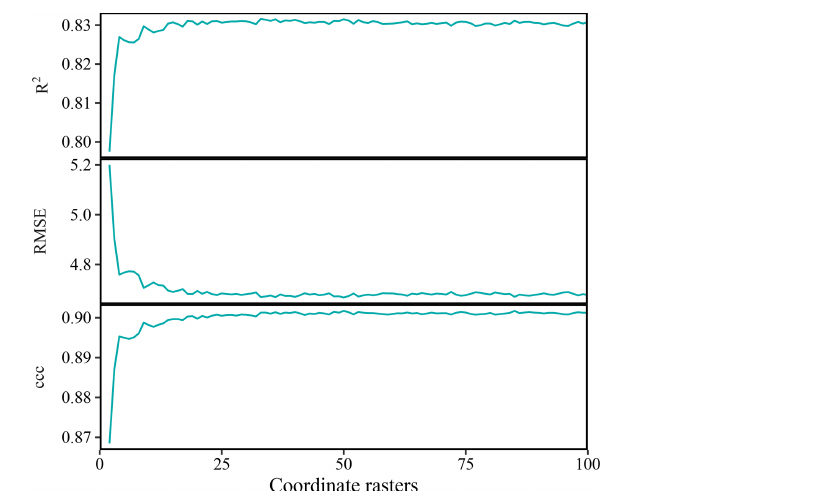
Figure A5. Accuracy of predictions on the Swiss rainfall dataset versus the number of rasters with oblique geographic coordinates. The values are averages obtained with 100 splits into training and test data.